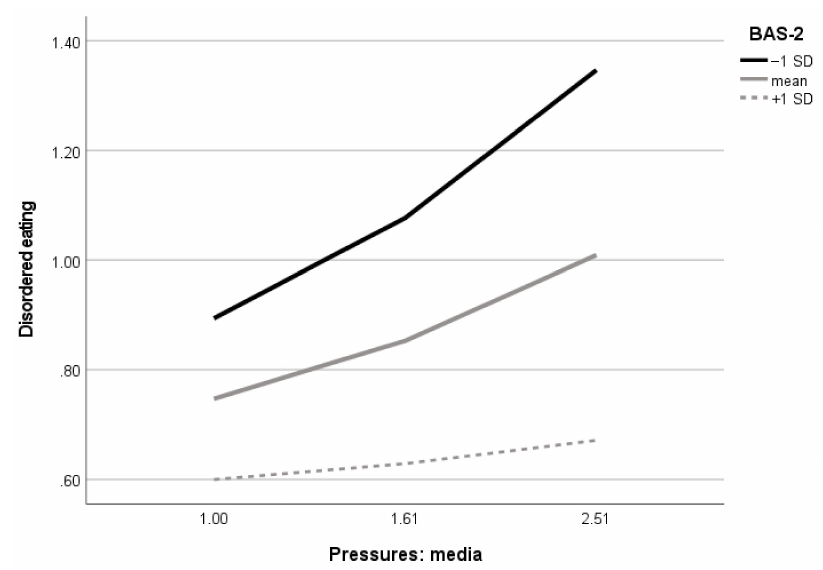
Figure 6. Visualization of body appreciation moderating effect in the association between perceived media pressures towards appearance and disordered eating in boys ( n = 570). BAS-2 = Body Appreci- ation Scale-2, SD = standard